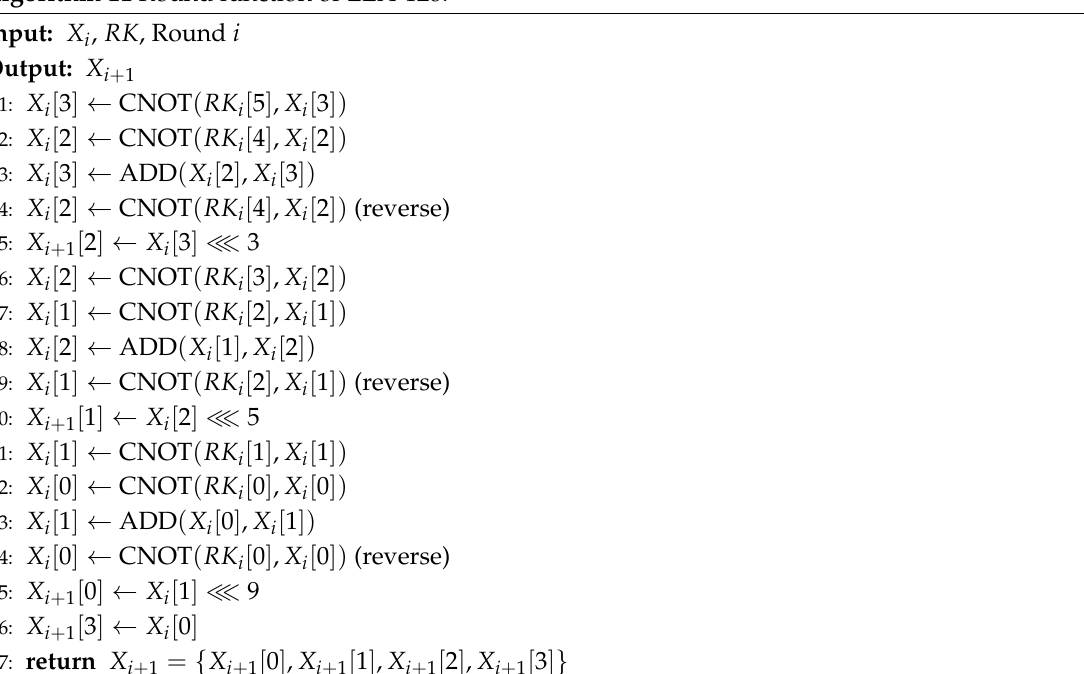
Algorithm 11 Round function of